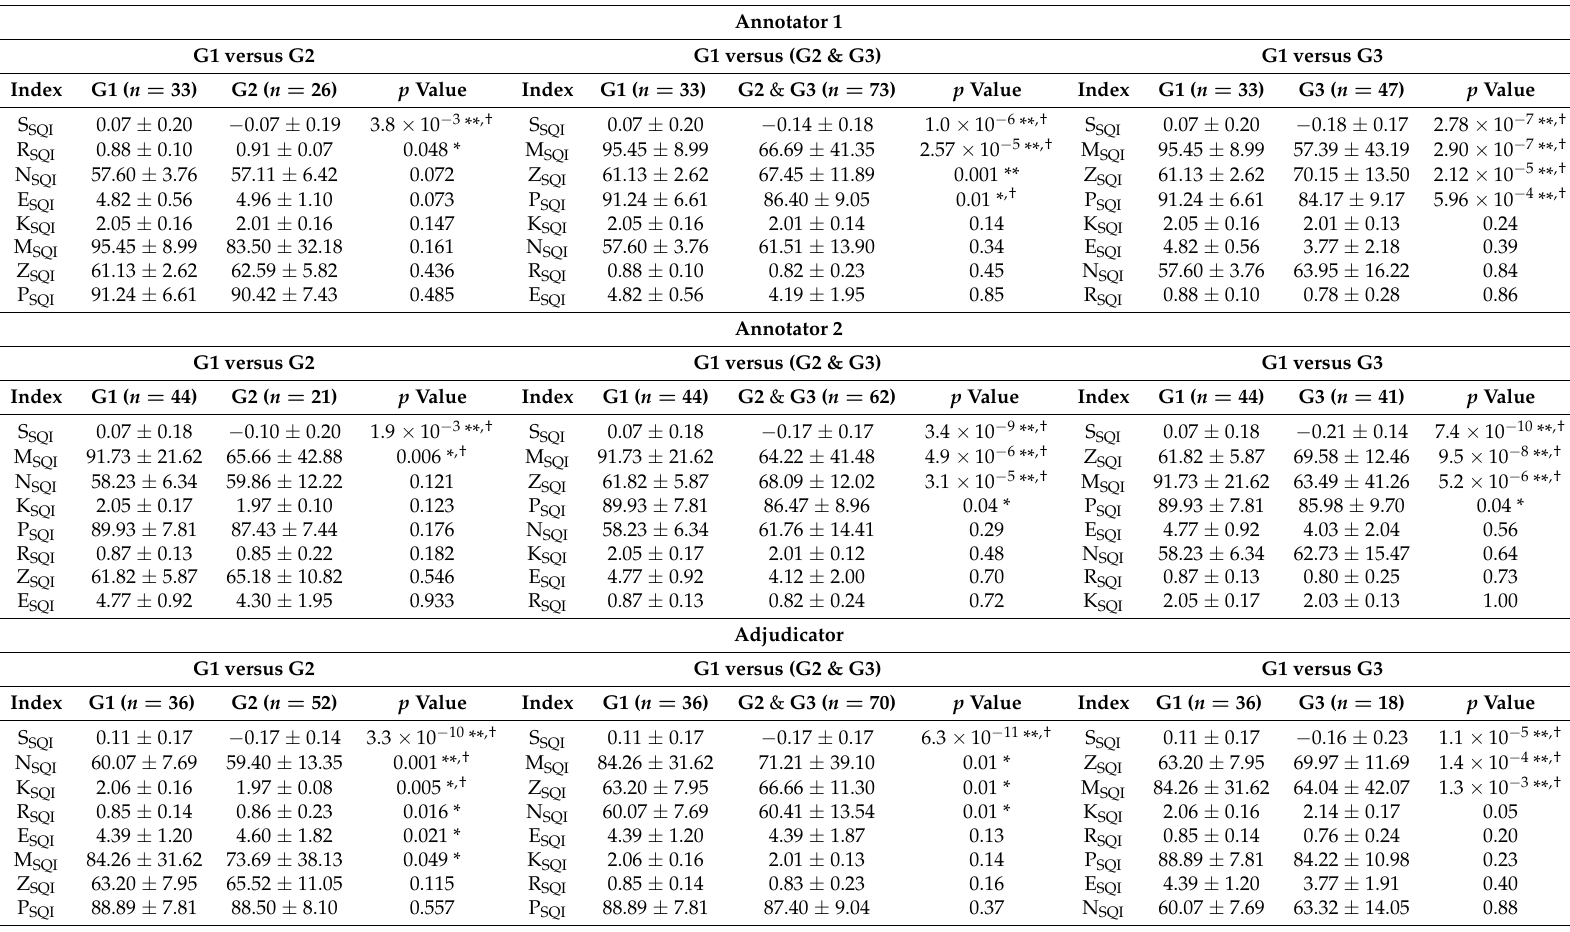
Table 2. Signal quality indices comparison of the annotators and the adjudicator ranked in ascending order based on the p